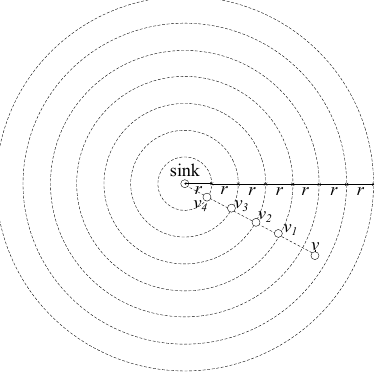
Figure 3. Zoning by the same r .